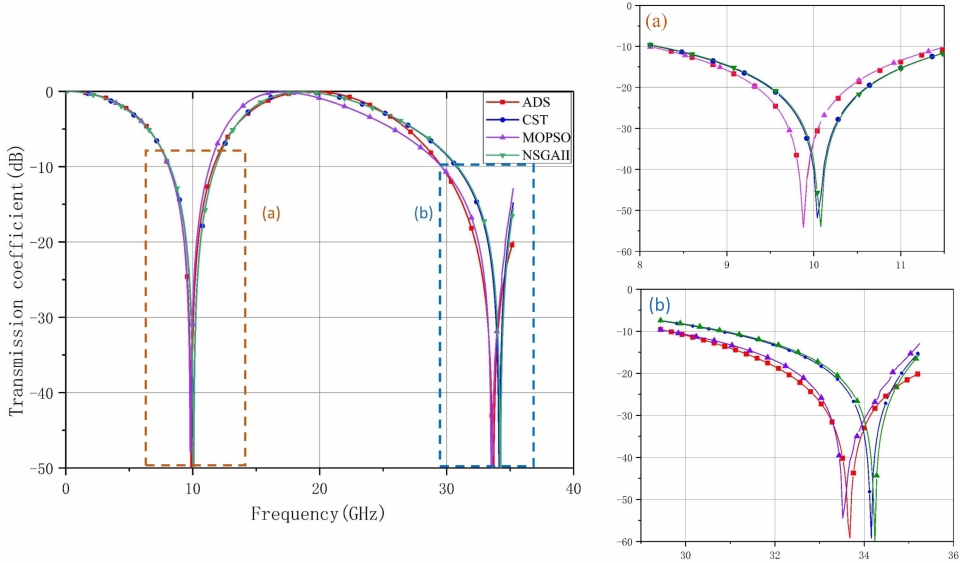
Figure 5. Comparison of transmission coefficients obtained from MOPSO, NSGAII, CST parameter scan optimization, and ECM in ADS. ( a ) Transmission coefficient in the frequency range of 8–11 GHz, ( b ) Transmission coefficient in the frequency range of 28.5–35